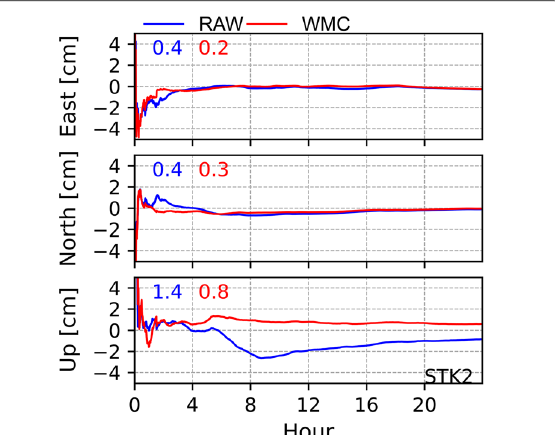
Fig. 12 Positioning error in the earth, north, and up components of multi-GNSS integrated PPP in static mode on January 1, 2018 for station STK2. ‘RAW’ indicates the PPP results using combined clocks without consideration of ASB and nonlinear variations, and the values in different colors indicate the RMS of position residuals